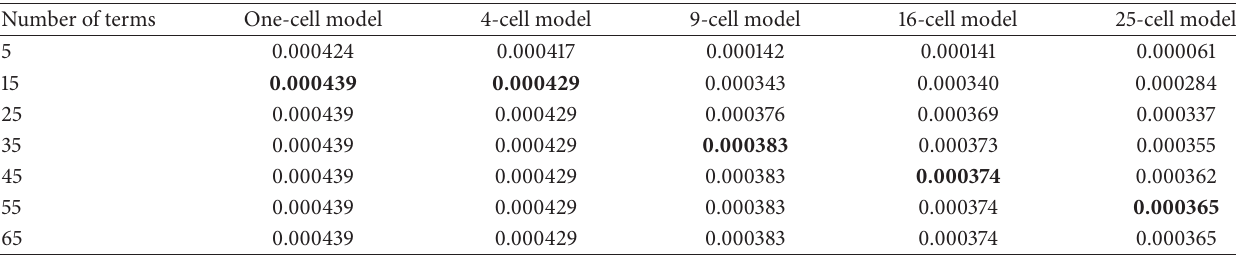
Table 1: Values of 𝑤/(𝑞𝑎 4 /𝐷) , at 𝑥 = 𝑎/4 , 𝑦 = 𝑏/4 .